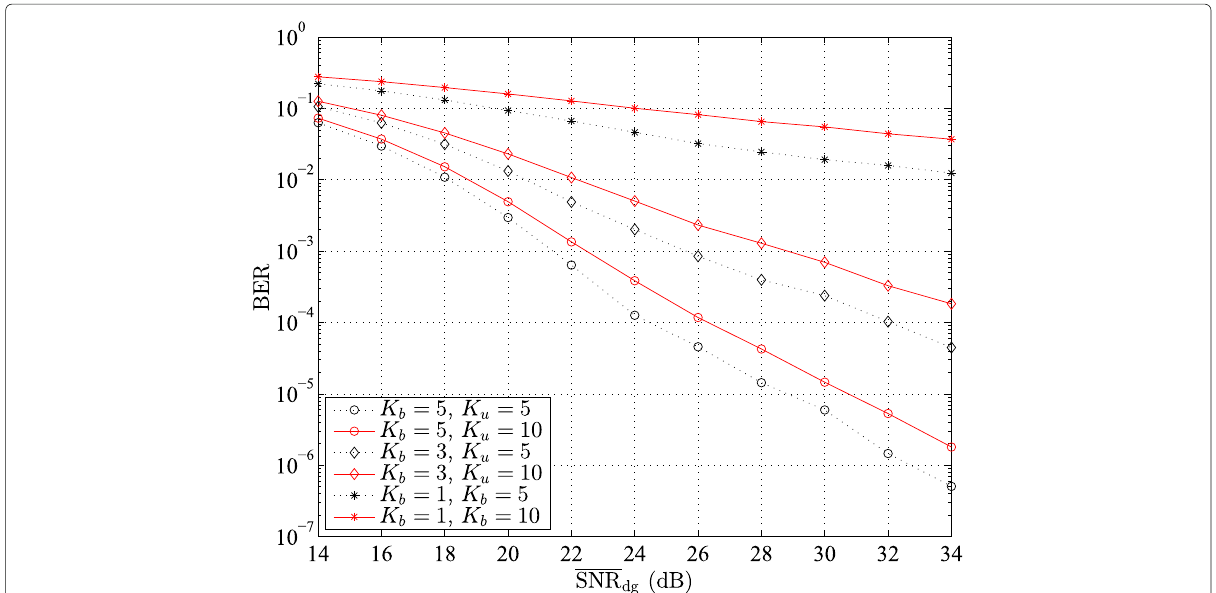
Fig. 8 BER versus designed SNR: multiuser scenario with different numbers of